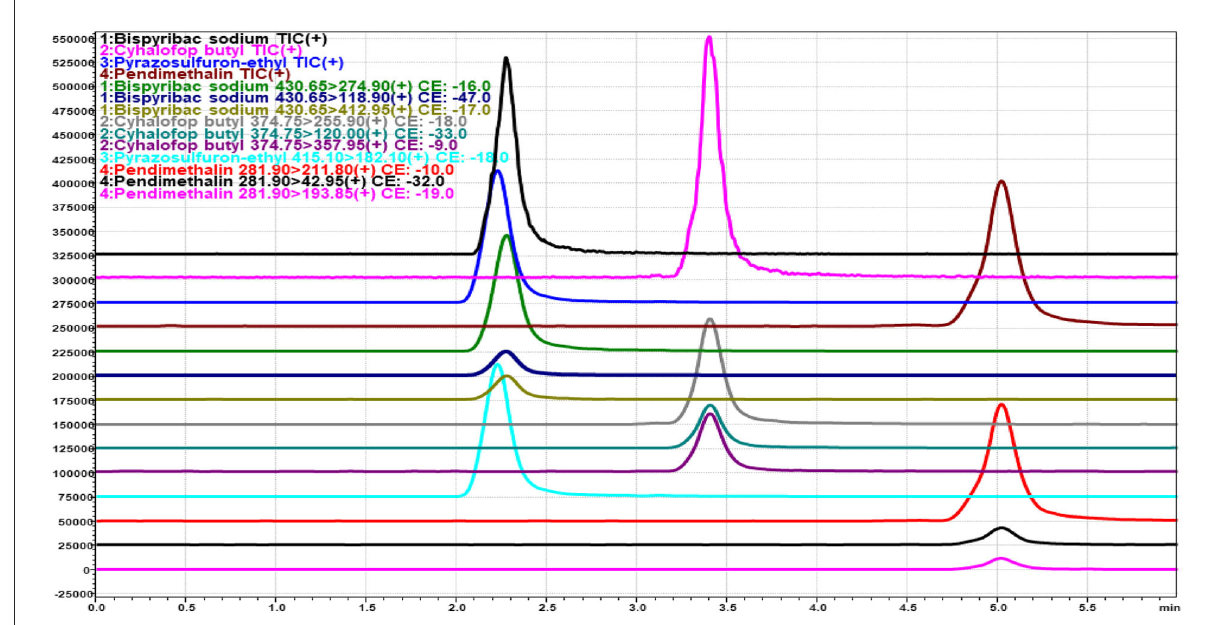
FIGURE1 Base shift chromatogram showing multiple reaction monitoring (MRM) transition of bispyribac sodium, cyhalofop-butyl, pyrazosulfuron-ethyl, and pendimethalin